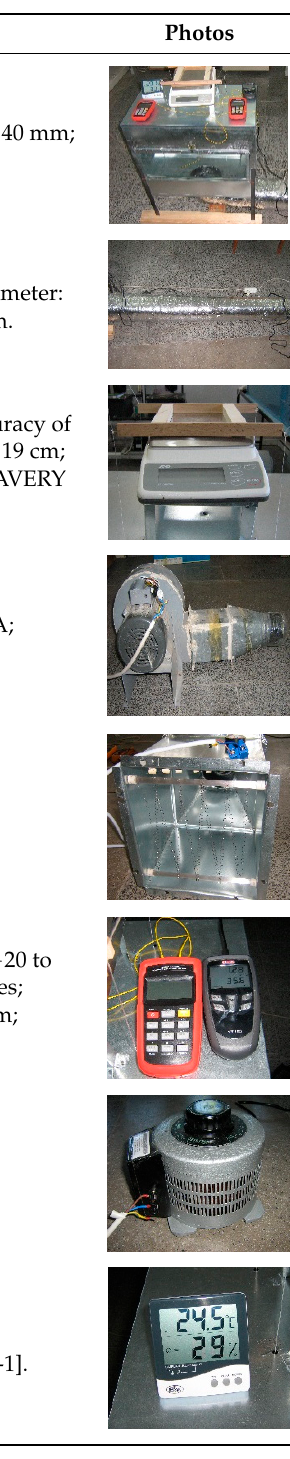
Table 2. Photos and technical specifications of the dryer